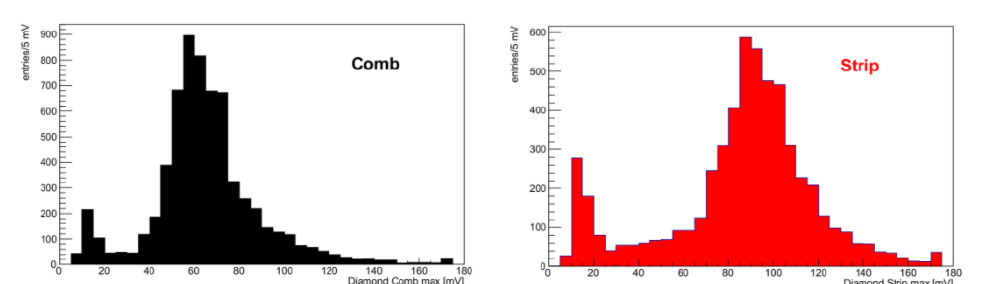
Figure 10. ( Left ): pulse height spectrum of the comb test structure. ( Right ): pulse height spectrum of the strip test structure.